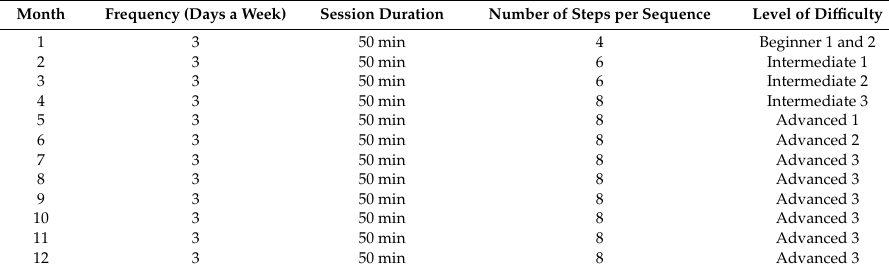
Table 1. Proposal progression of Tele-SSE